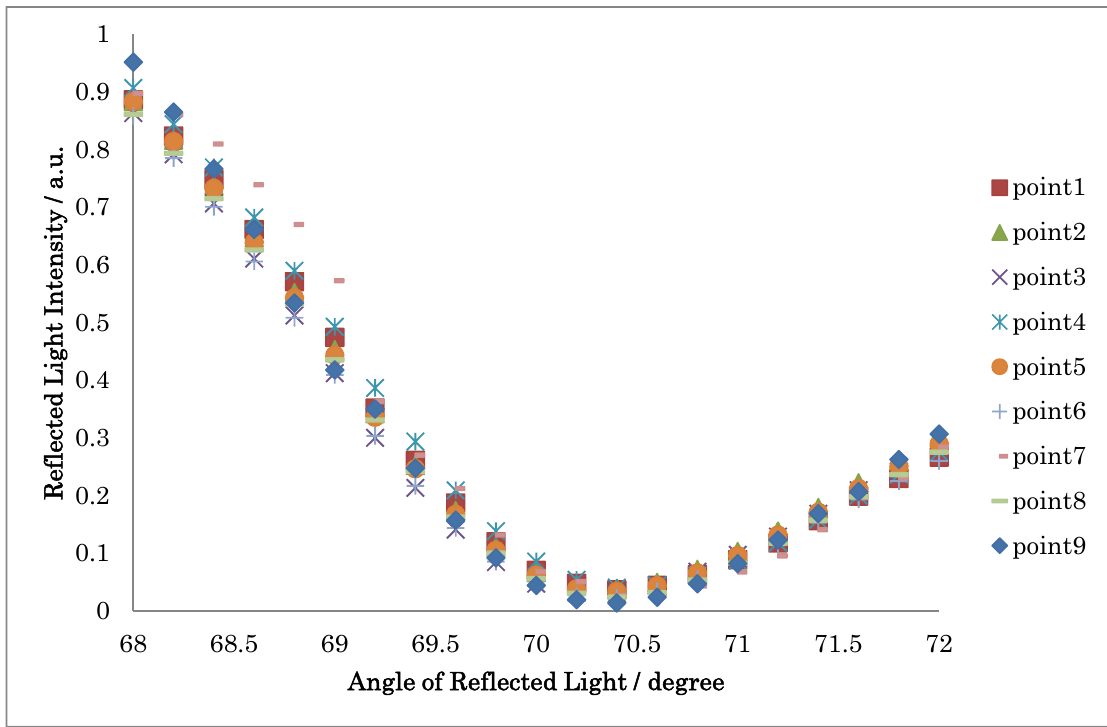
Figure 7. The SPR curves for nine measurement